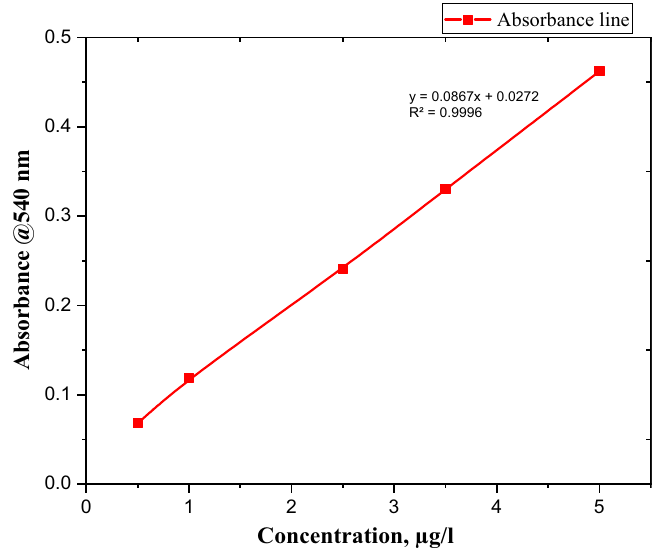
Figure 4. Standard calibration curve spiked with different volumes at λ-max 540 nm.